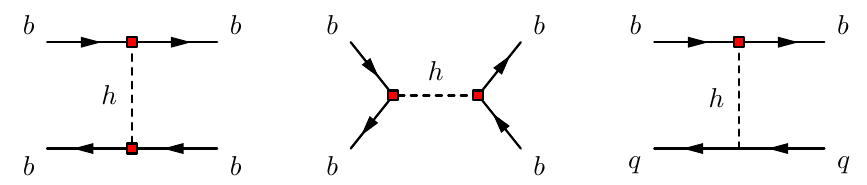
Figure 2 . Sample tree-level Feynman diagrams contributing to the calculation of the initial condi- tions of the RG evolution at the electroweak scale for the case of modified bottom-quark Yukawas (indicated by the red square). Light quarks are denoted by the label q = u, d, s . is computed using the appropriate anomalous dimensions, following the general formalism outlined in ref.